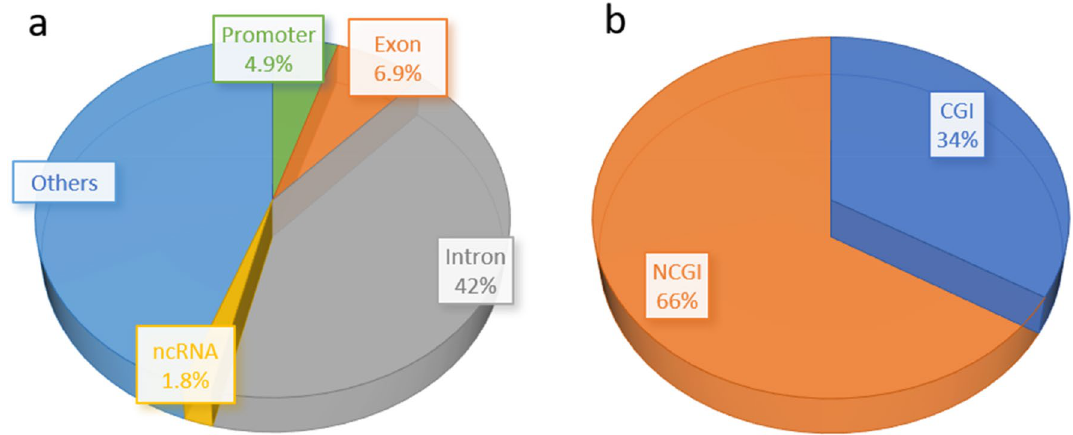
Figure 1. Percentage of CpG sites analyzed in this study in each category of ( a ) genomic features and ( b ) CpG islands.